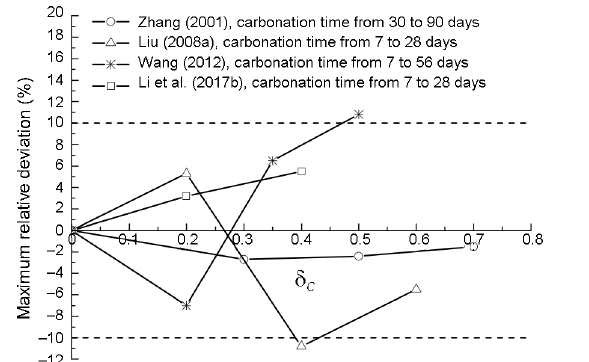
Figure 6. Influence of carbonation time on stress influence coefficient under compressive stress